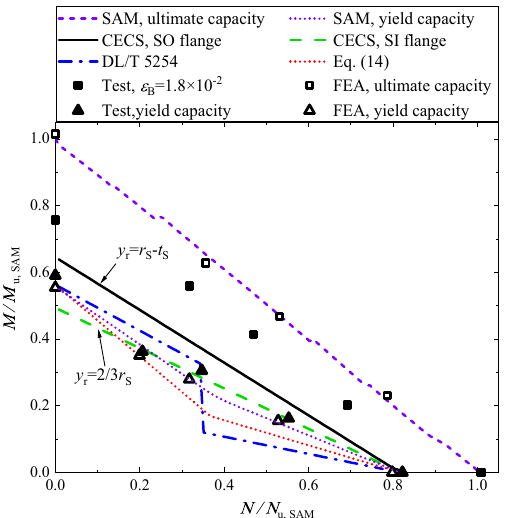
Figure 20. Interaction of bending capacity with tensile capacity, given specimens in Ref 25